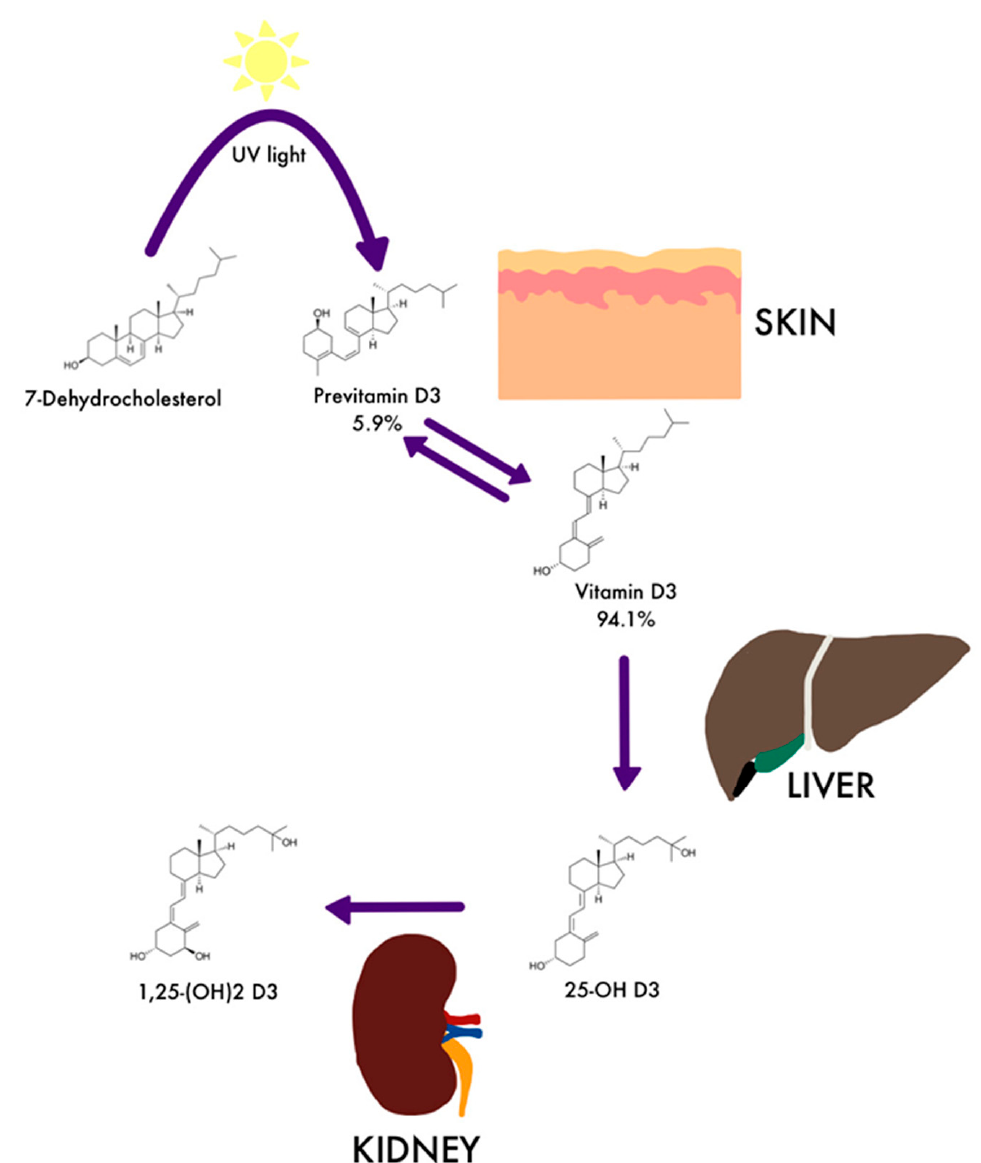
Figure 1. Vitamin D, liver, and renal metabolism (Adapted with permission from [12]).